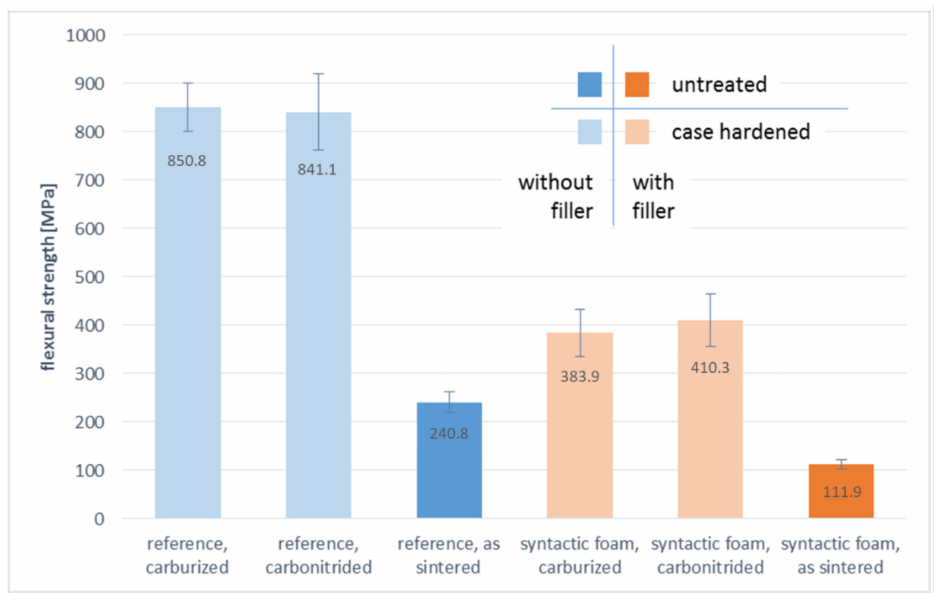
Figure 15. Bending limit of the different material batches (with standard